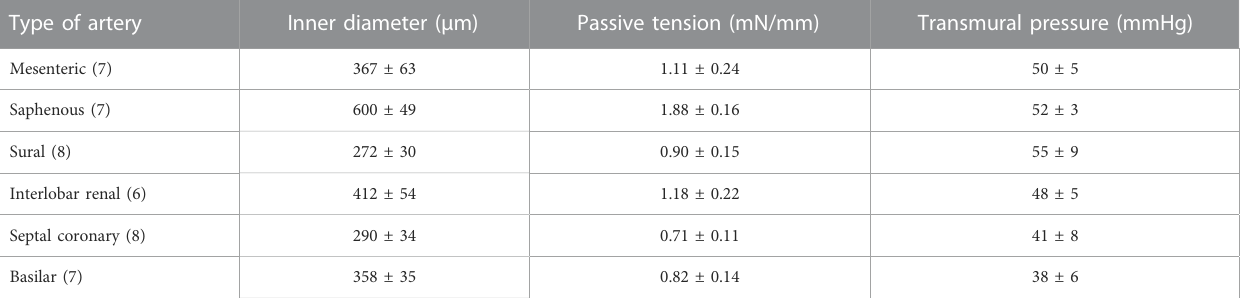
TABLE 1 The characteristics of different rat arteries stretched to an internal circumference of 0.9*IC 100 : values of inner diameter, passive tension and corresponding levels of transmural pressure calculated according to Laplace ’ s